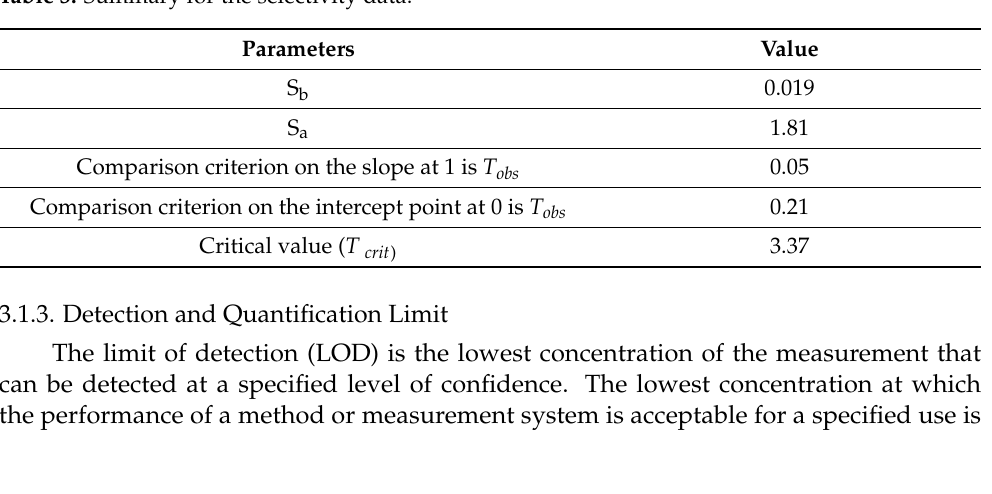
Figure 1. HPLC chromatogram of a hair dye sample showing the peak of PPD at 6.4 min. Table 3. Summary for the selectivity data. Table 3. Summary for the selectivity